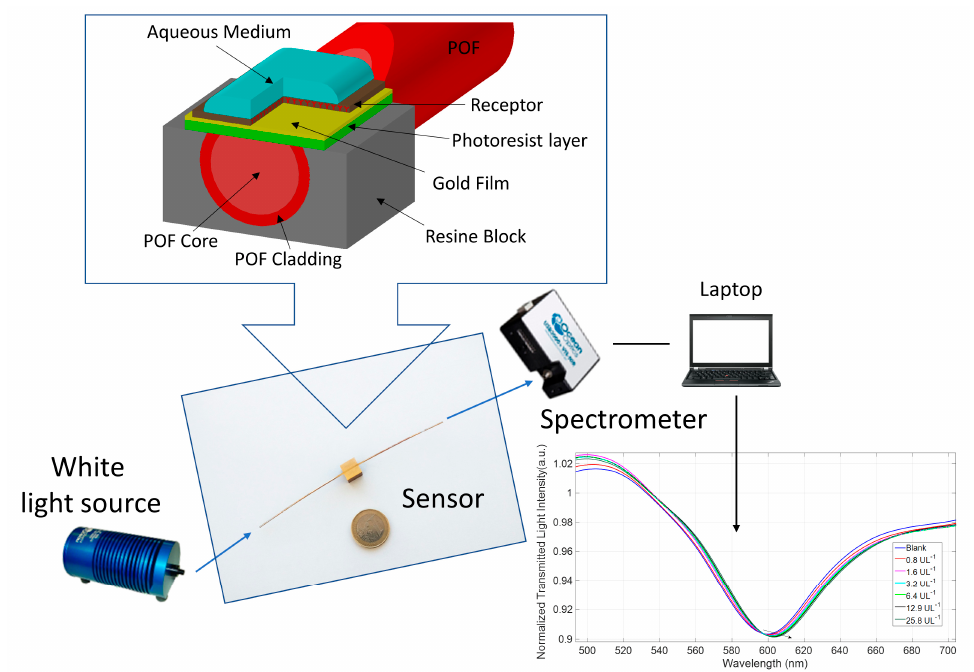
Figure 5. Setup of the POF-biosensor, as described in [14], with the equipment. The upper inset shows the cross section of the SPR-POF